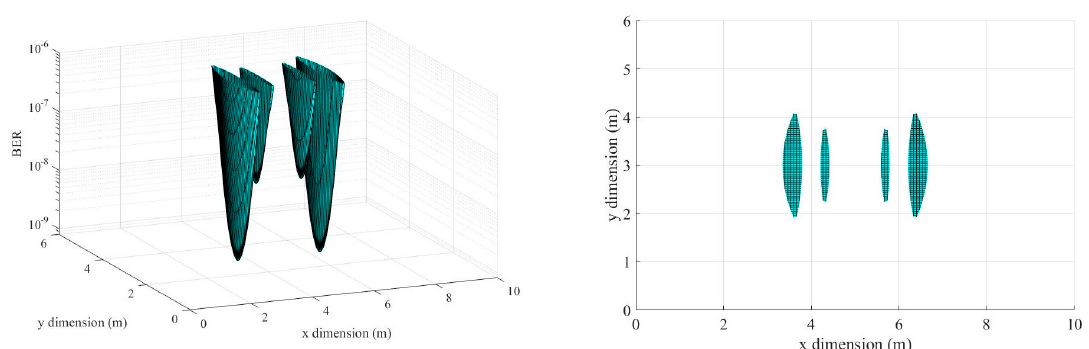
Figure 6. Areas with a bit error rate (BER) ≤ 1 × 10 − 6 for the case where no filter is applied in the visible light communication (VLC) system.